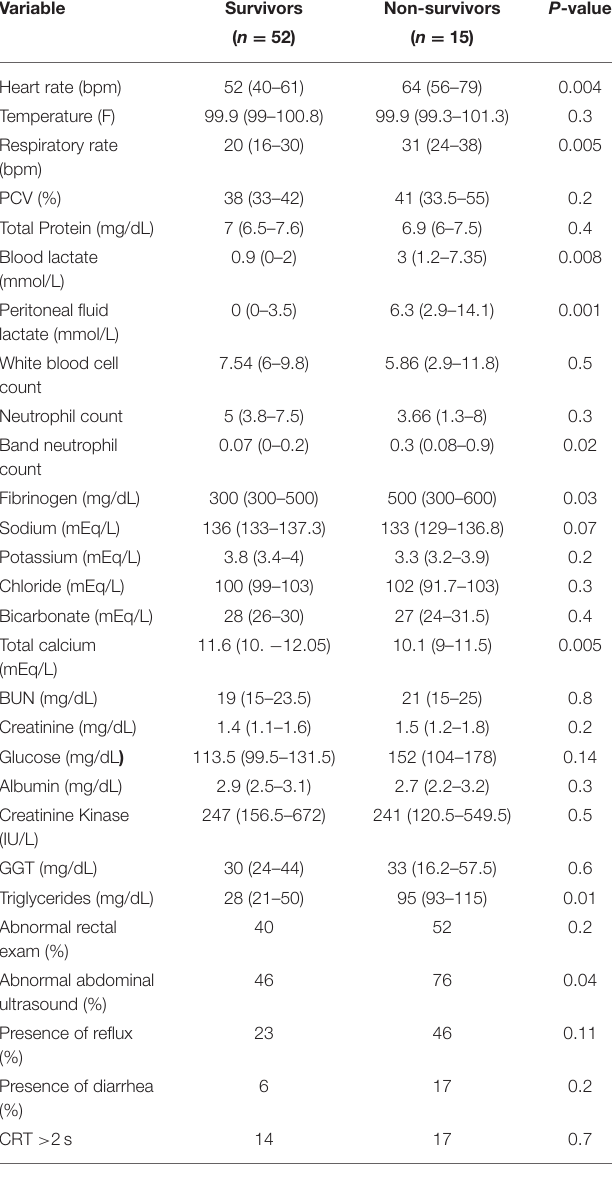
TABLE 1 | Laboratory and clinical variables categorized by outcome in horses presented for colic in the retrospective study (median and interquartile range).